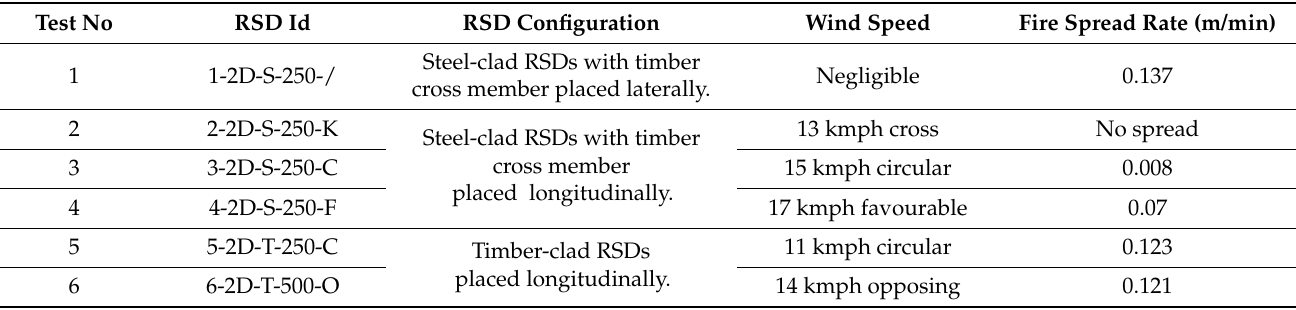
Table 3. Test matrix of two RSD